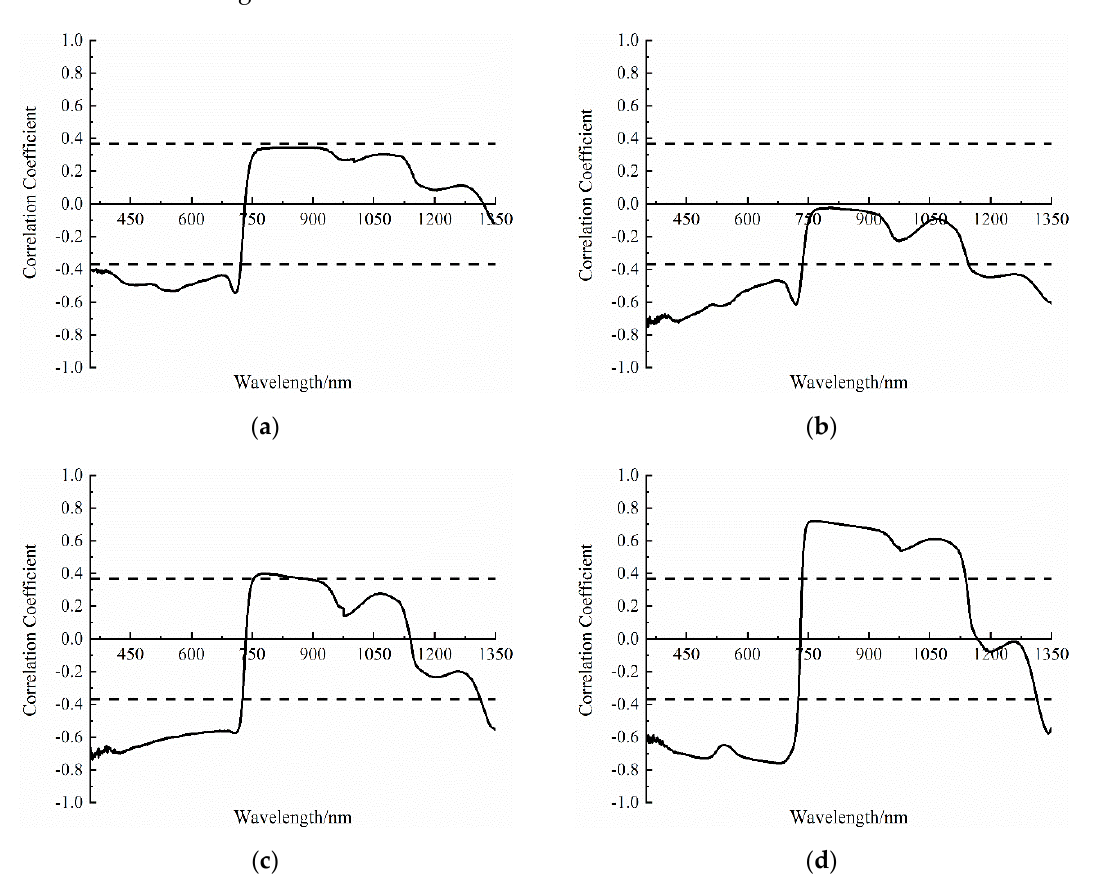
Figure 2. Correlation analysis of the raw hyperspectral with LWC in four growth periods. ( a ) Jointing period; ( b ) booting period; ( c ) flowering period; ( d ) filling period.